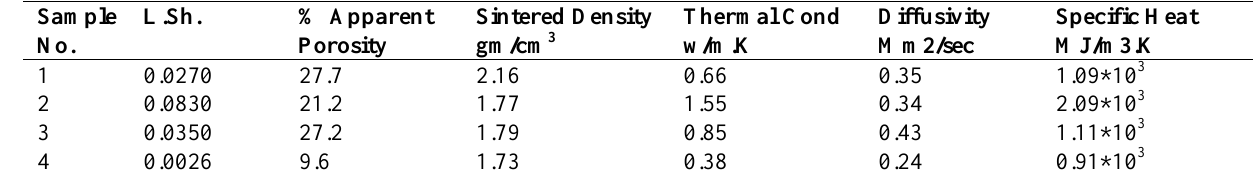
The physical and thermal properties for the bauxite based prepared